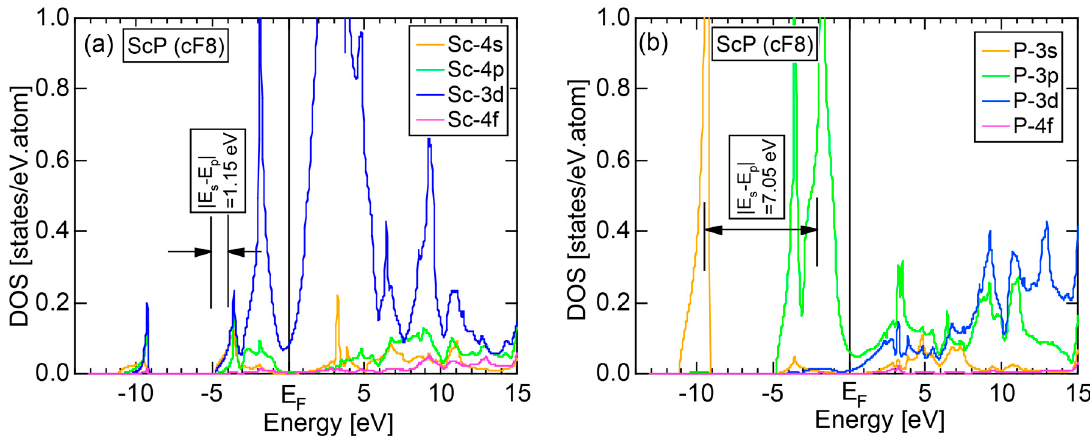
Figure 70. ( a ) Sc- and ( b ) P-pDOSs for ScP (cF8). The corresponding separation energies are also indicated [11,12].